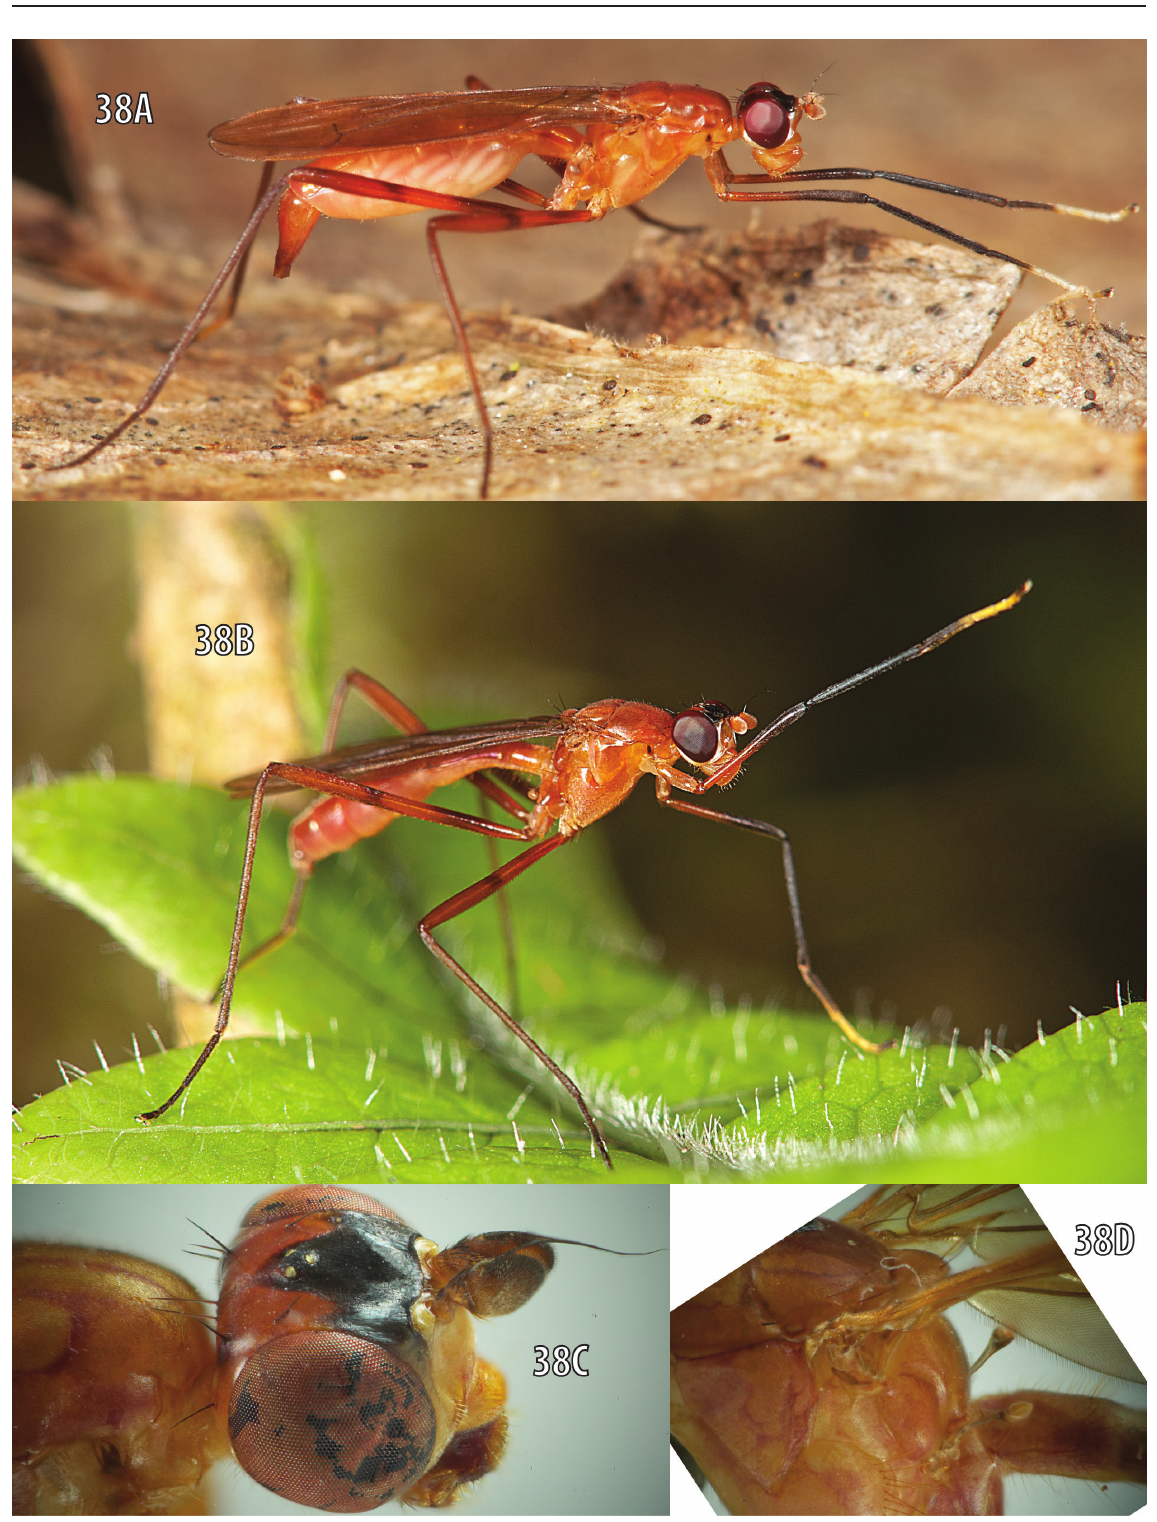
Fig. 38. Mesoconius zorro sp. nov., external characters . A . Paratype prior to capture, ♀, DEBU. B . ♂ prior to capture. C . Head. D . Posterior thorax and base of